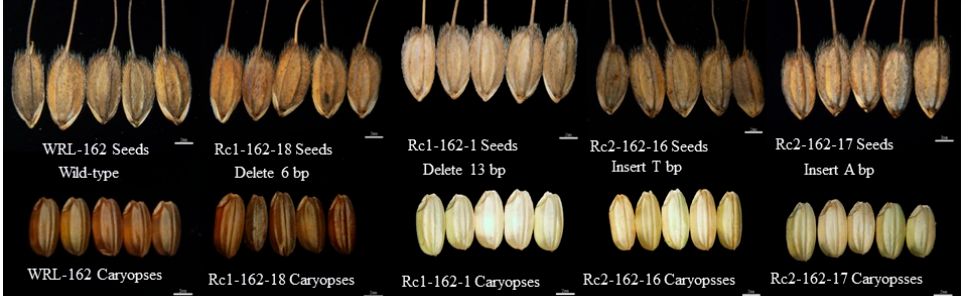
Figure 2. Seeds and caryopses of wild type and T3 mutants. Note: Wild type is Wrl-162. Mutants are Rc 1-162-18, Rc 1-162-1, Rc 1-162-16, and Rc 1-162-17. Rc 1 and Rc 2 represent regenerated plants from the Rc gene knockout vectors pRGEB32- Rc 1 and pRGEB32- Rc 2, respectively.